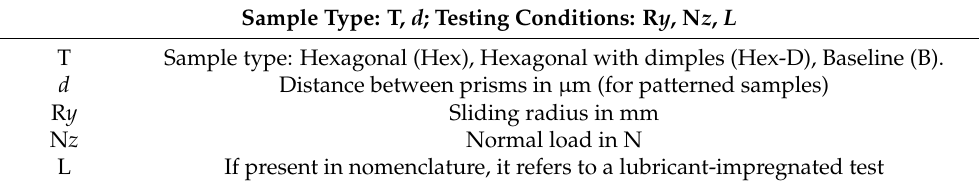
Table 5. Nomenclature for tribological tests.